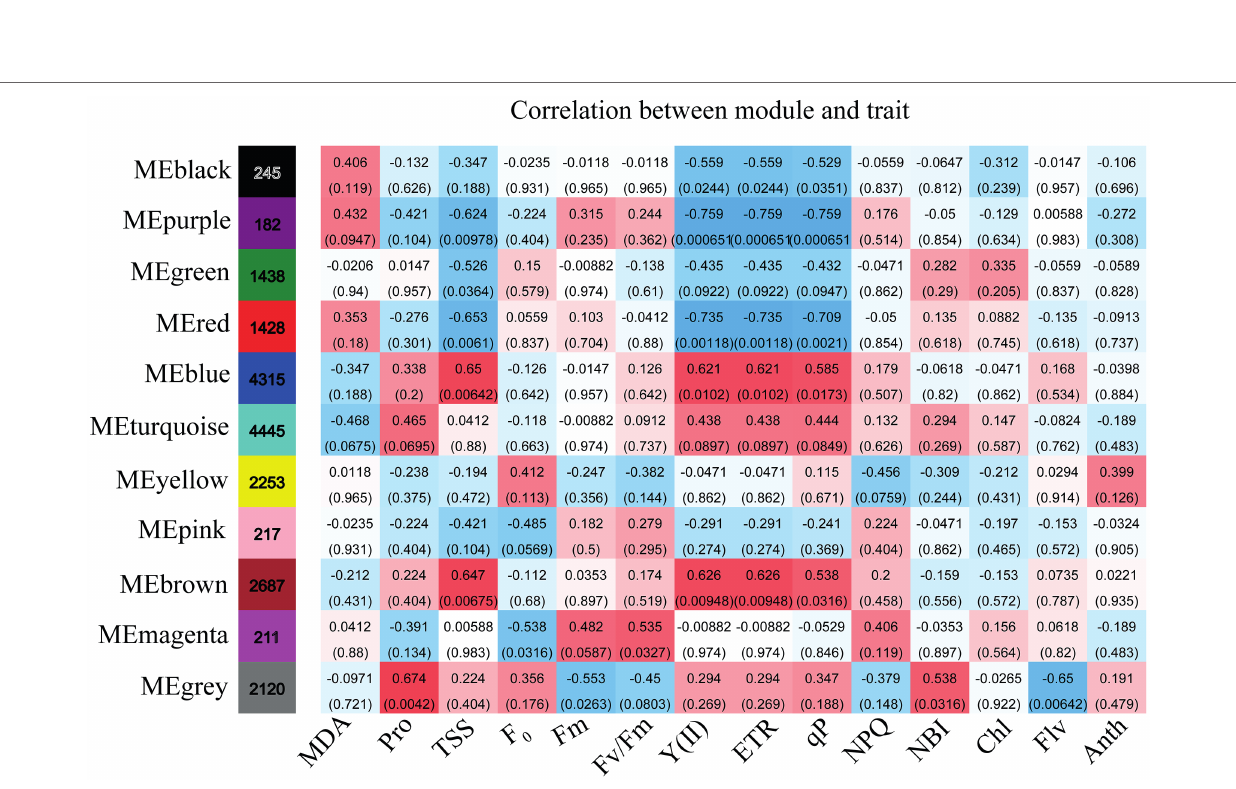
FIGURE 5 | The changes in physiology under drought stress are correlated with co-expression networks. Each row corresponds to a module labeled with a color, and it is distinguished by different colors which were arbitrarily assigned by the WGCNA package. Each column corresponds to a tissue type as indicated. The color of each cell at the row–colum intersection indicates the correlation coefficient (R) between the module and the tissue